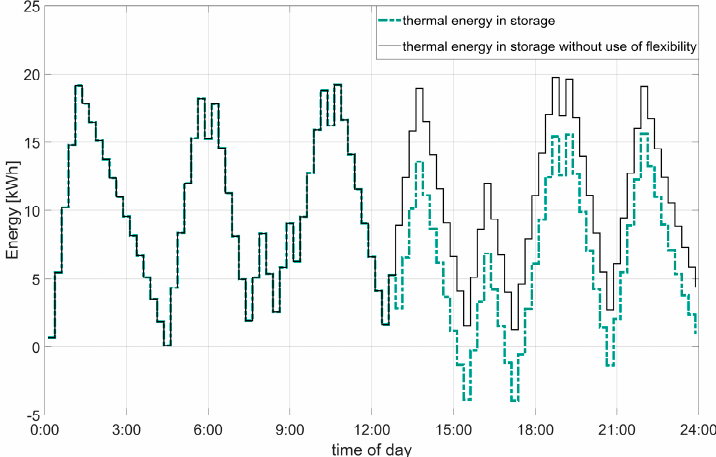
Figure 3. Thermal energy in the storage with (dashed line) and without the use of flexible power.